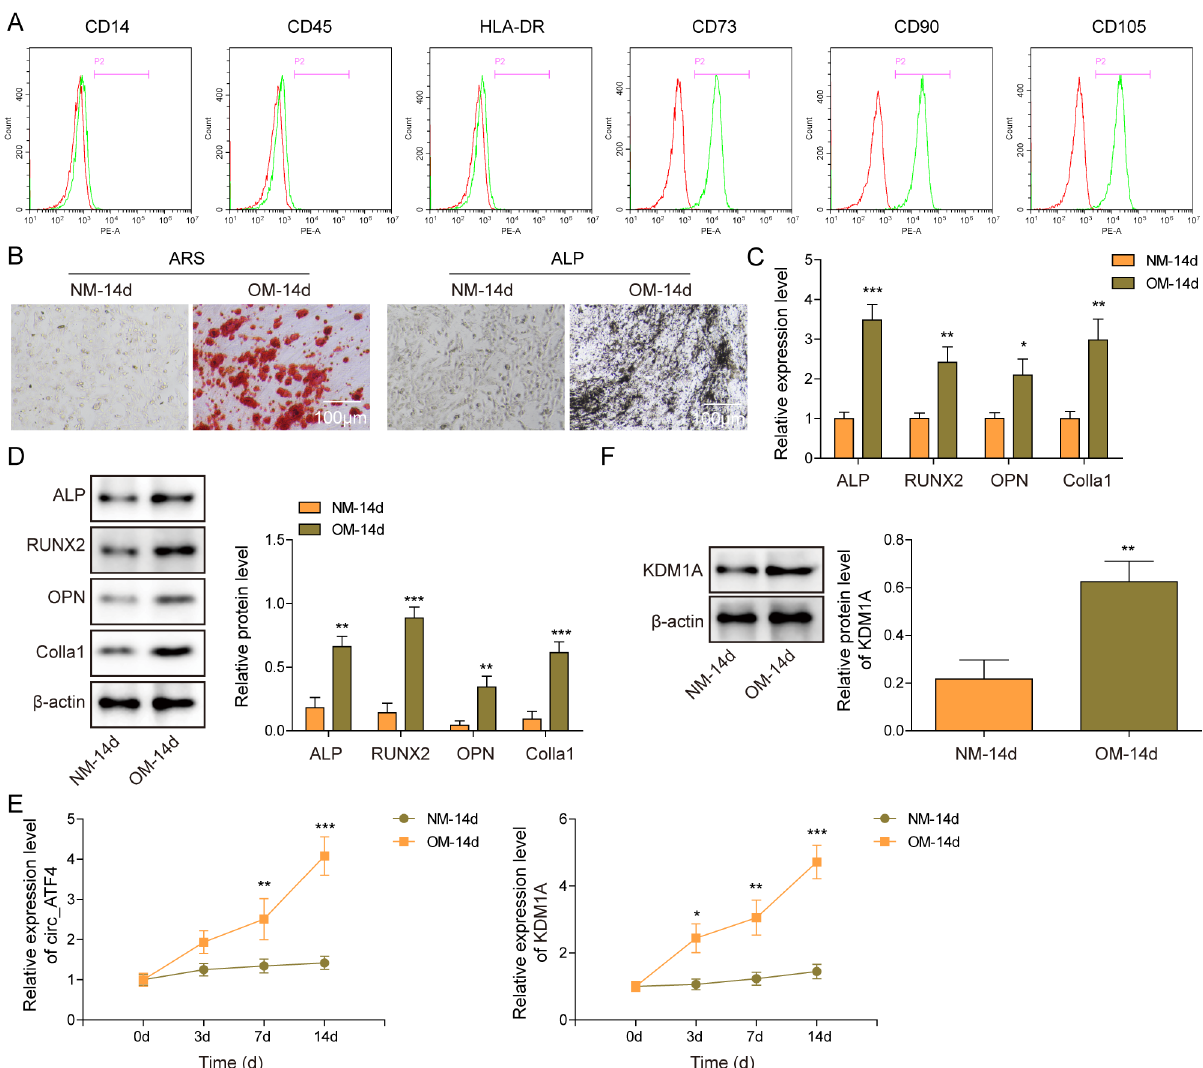
Fig. 1 Circ_AFF4 and KDM1A were significantly increased in BM-MSCs upon osteoinduction ( A ) Protein expression of cell surface markers, CD14, CD45, HLA-DR, CD73, CD90 and CD105, in BM-MSCs was assessed by FACS. ( B ) Representative images of ARS and ALP staining of BM-MSCs cultured in osteogenic medium (OM) or normal medium (NM) for 14-days. Scar bar = 100 μm. Relative gene ( C ) and protein ( D ) expression of osteogenic markers, ALP, RUNX2, OPN and Colla 1, in BM-MSCs cultured in OM or NM for 14-days, were detected by RT-qPCR and western blot, respectively. ( E ) Relative gene expression of circ_AFF4 and KDM1A were assessed by RT-qPCR in BM-MSCs cultured in OM or NM after 0, 3, 7 and 14 days. ( F ) Relative protein expression of KDM1A was detected by western blot in BM-MSCs cultured in OM or NM after 14 days. * p < 0.05, ** p < 0.001 and *** p < 0.001. Each experiment was performed at least three times